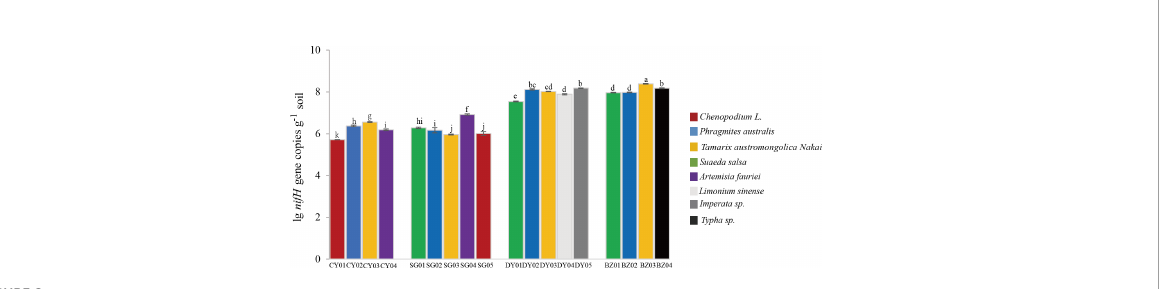
FIGURE 2 Quanti fi cation of nifH gene in the rhizospheric soil samples collected at different locations. Four sampling locations, Changyi (CY) and Shouguang (SG) with silt and low or non-saline soils, and Dongying (DY) and Binzhou (BZ) with rigid and high salinity soils, were selected. CY01, CY02, CY03, CHY04, SG01, SG02, SG03, SG04, SG05, DY01, DY02, DY03, DY04, DY05, BZ01, BZ02, BZ03 and BZ04 represent the soil samples respectively collected from the four locations. Values were means and standard deviations of three biological replicates (n=3). Lowercase letters